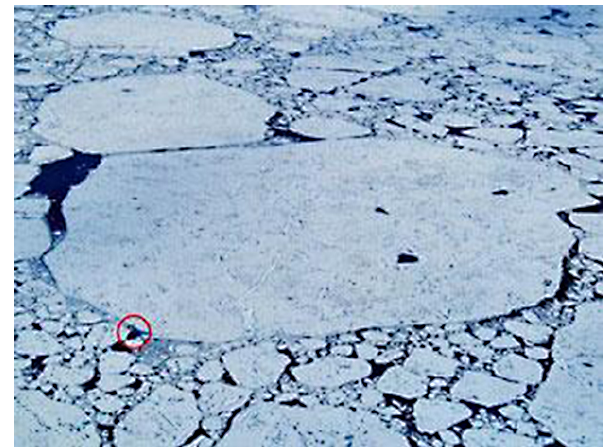
Fig. 3. During the ASCOS field campaign, the surface was to 90– 100% covered by sea ice. The red circle shows the position of the icebreaker Oden during the ice